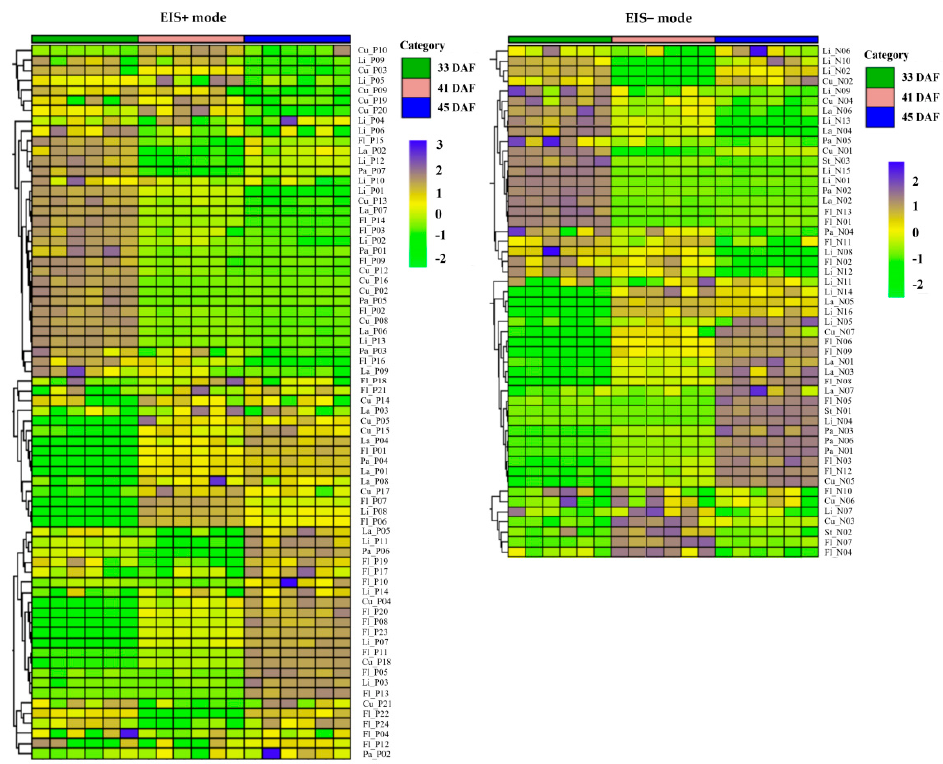
Figure 4. The cluster heatmap of phenylpropanoids metabolites at the three developmental stages of apricot endocarp. The peak area data of metabolites were standardized by Z cores during cluster analysis. Detailed data of metabolite was shown in Supplementary Table S2.